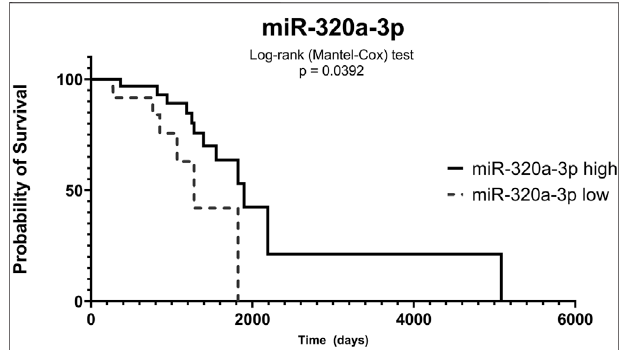
FIGURE 3 | Low expression of miR-320a-3p in serum is correlated with poor overall survival. The serum samples of breast cancer patients (BC-S) were divided into groups based on miR-320a-3p expression levels (high — straight line; low — dotted line). Time was evaluated in days and probability in percentage (%) of